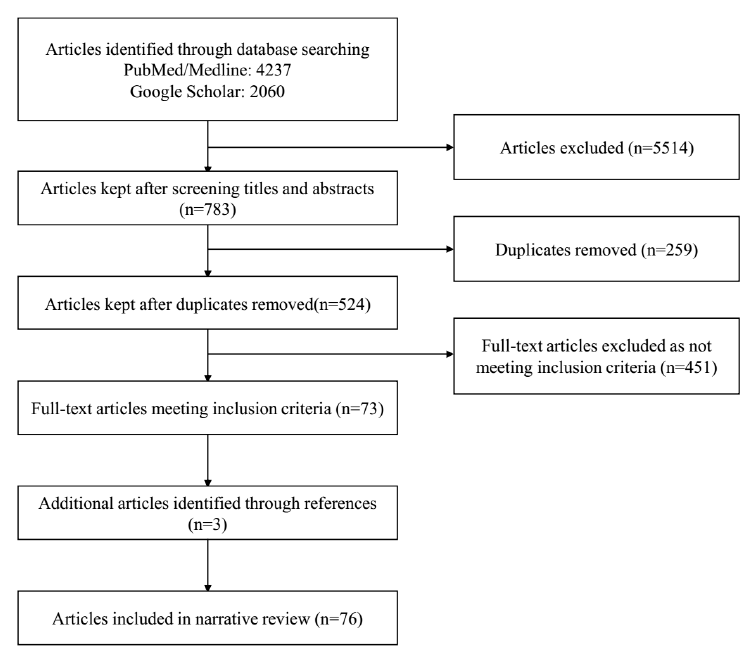
Figure 1. PRISMA flow diagram.